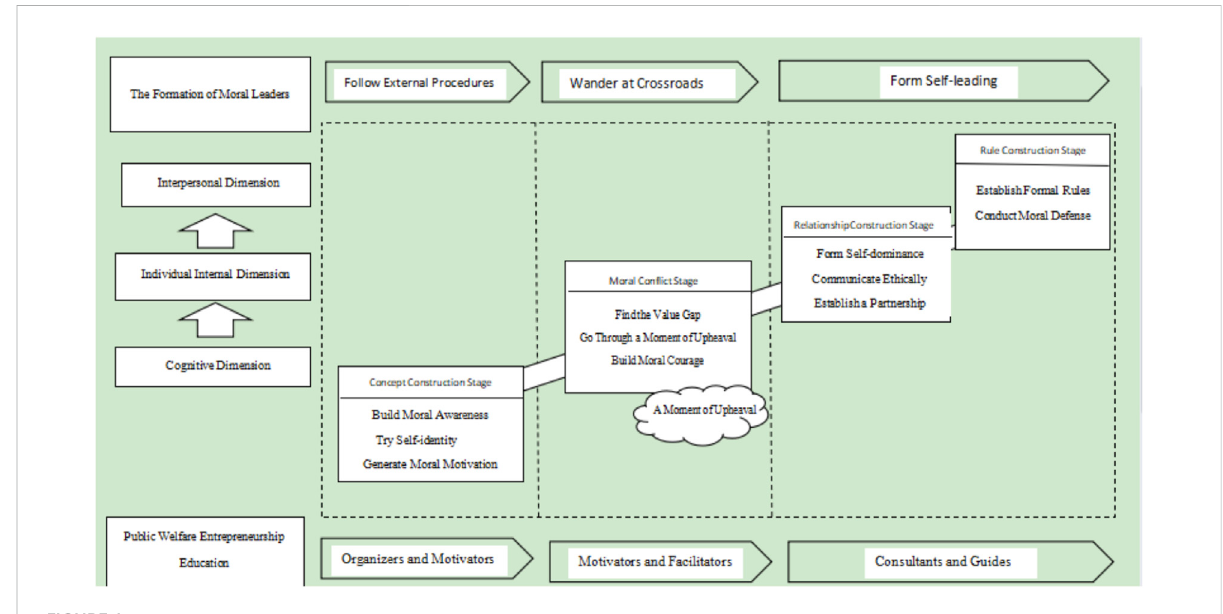
FIGURE 1 “ Moral leader ” development model based on personal